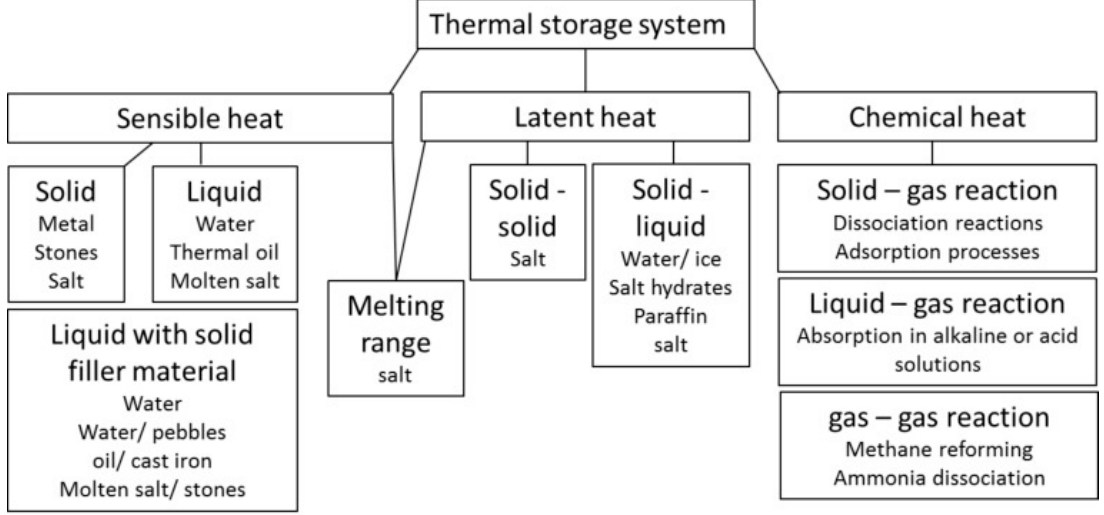
Figure 1. Thermal energy storage (TES) technologies [5].